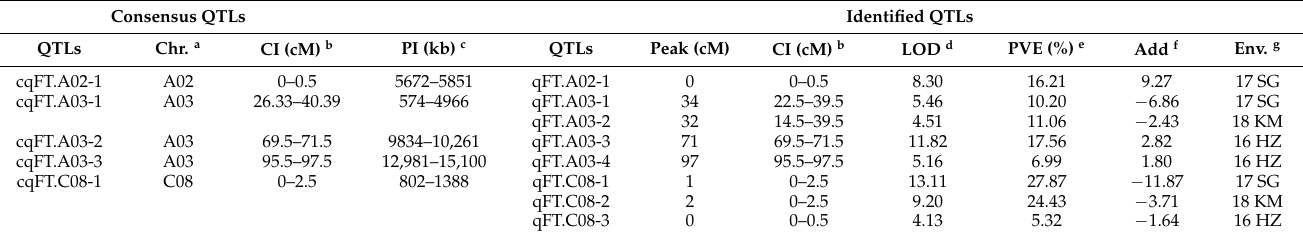
Table 2. Summary of the consensus QTLs and identified QTLs in three